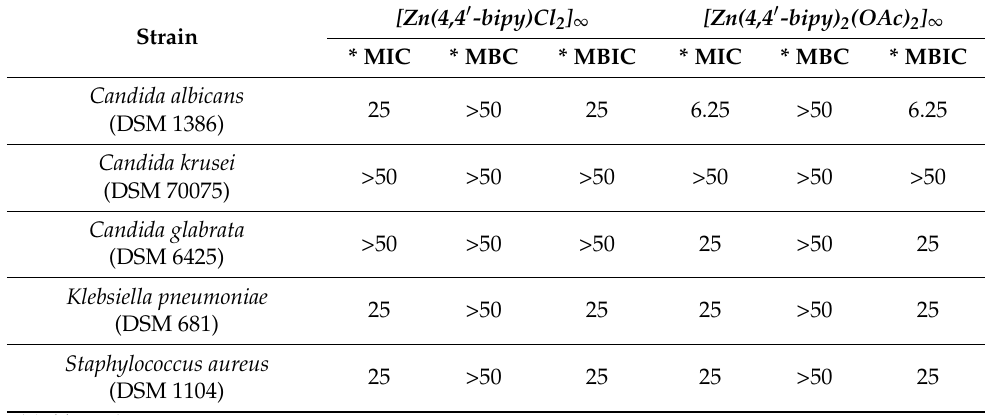
Table 3. Percentage dilution values for MIC, MBC, MBIC calculated for each tested compound.